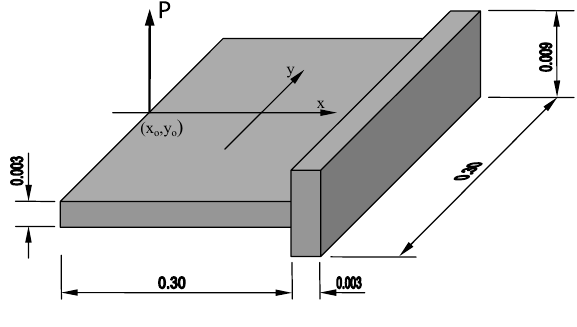
Fig. 2. Reinforced plate dimensions.